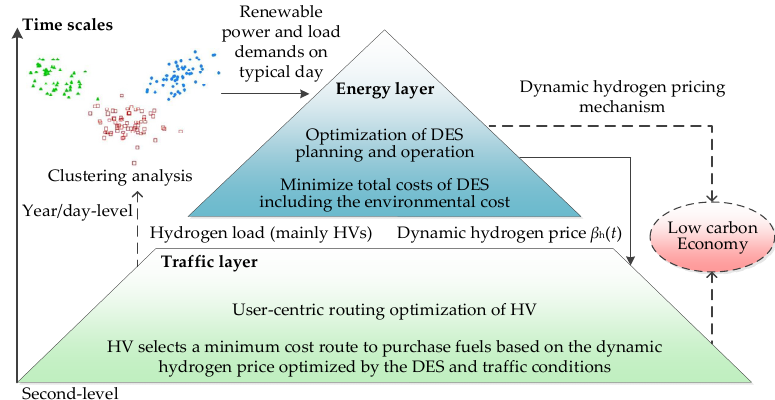
Figure 1. Proposed time-decoupling layered optimization strategy.